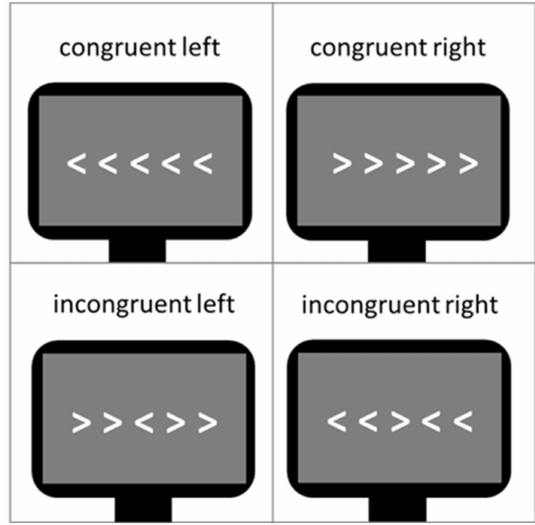
Figure 3. Flanker task conditions.